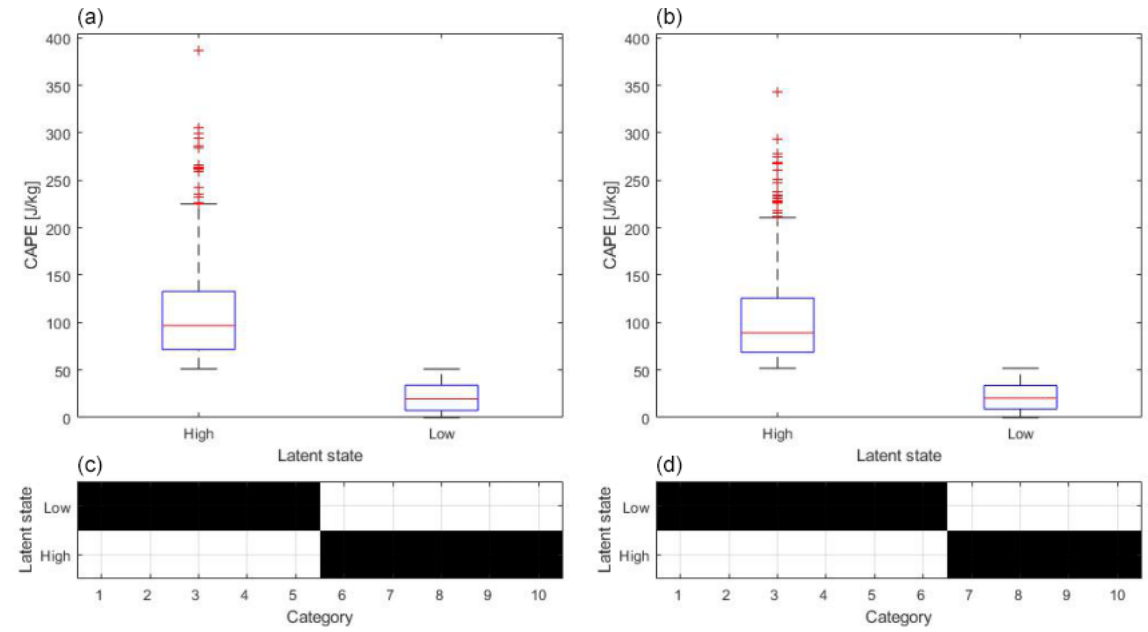
Figure 5. (a, b) Box plots show the 12h averaged CAPE data which is affiliated to the high and low latent states. Panel (a) presents day data and panel (b) the night data. (c, d) Affiliation of CAPE categories to the latent states. CAPE data are spatially averaged over the northwest quadrant of the COSMO-REA6 data, and the vertical velocity is averaged for a box discretization of 64 grid boxes; see Table